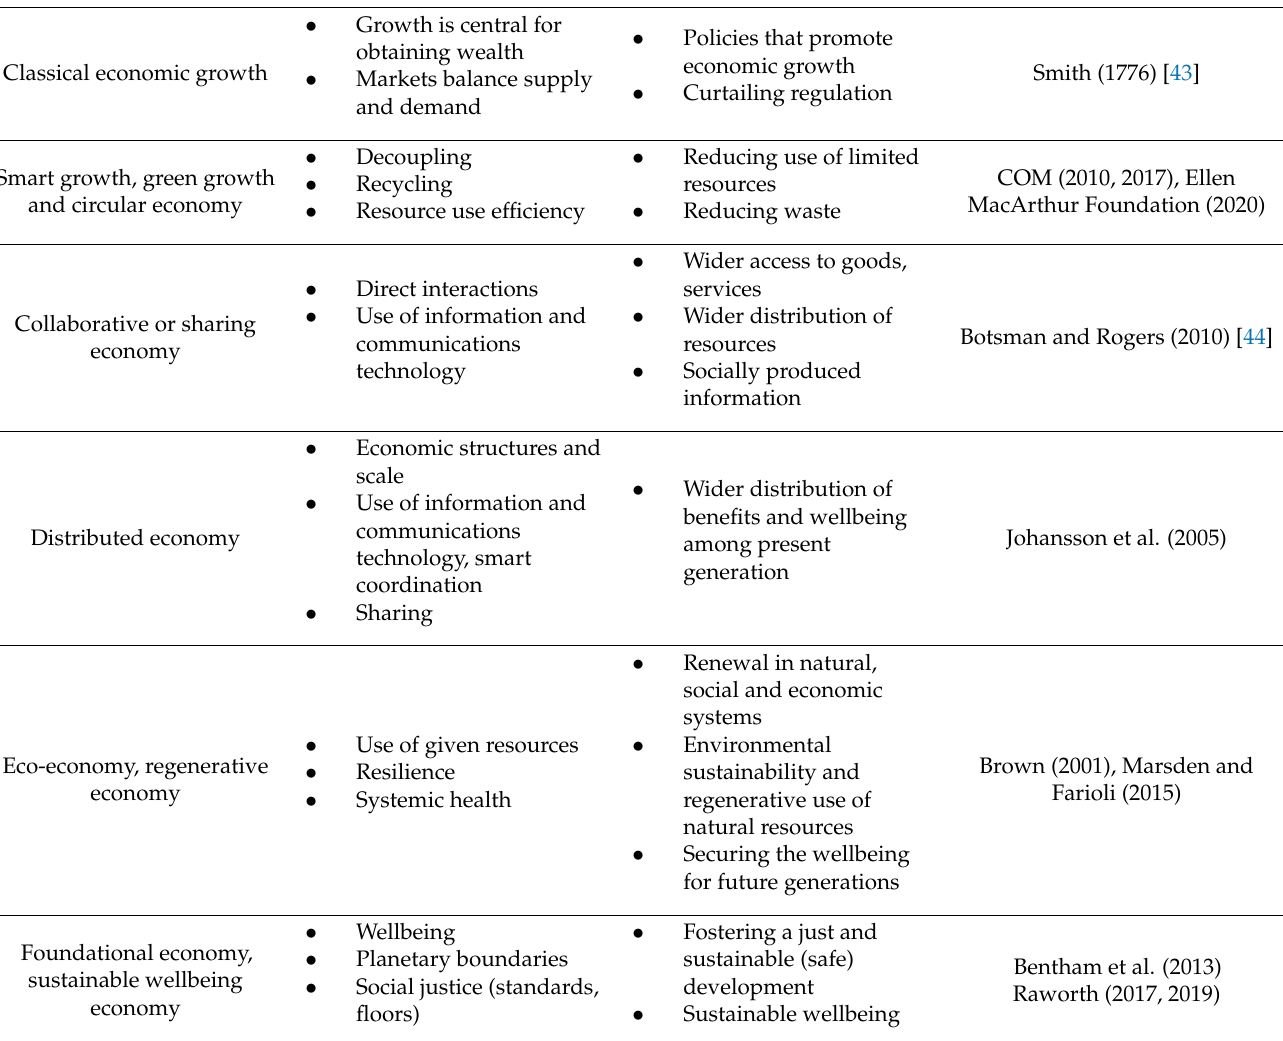
Table A1. Framing of each model, key focus areas and key references. Model Key Focus and